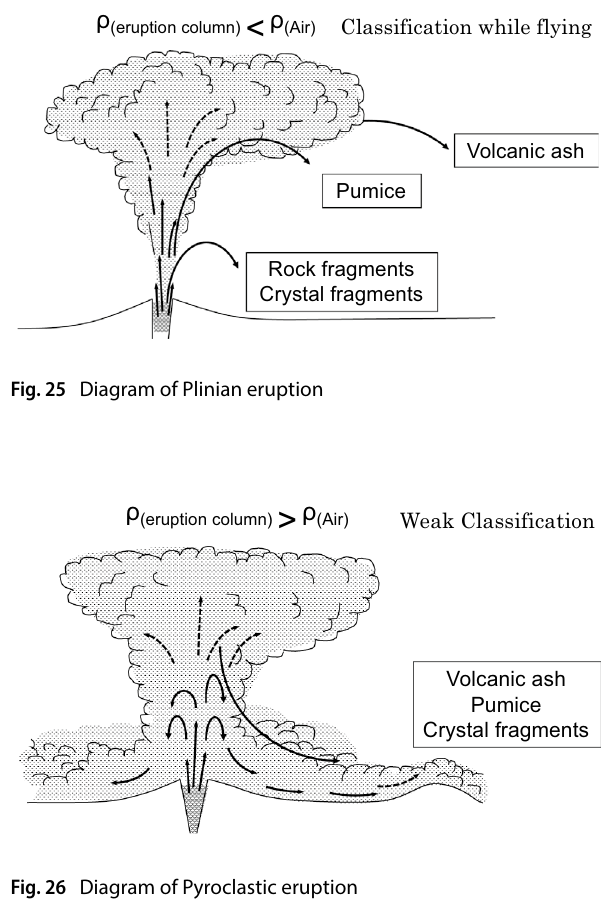
Fig. 26 Diagram of Pyroclastic